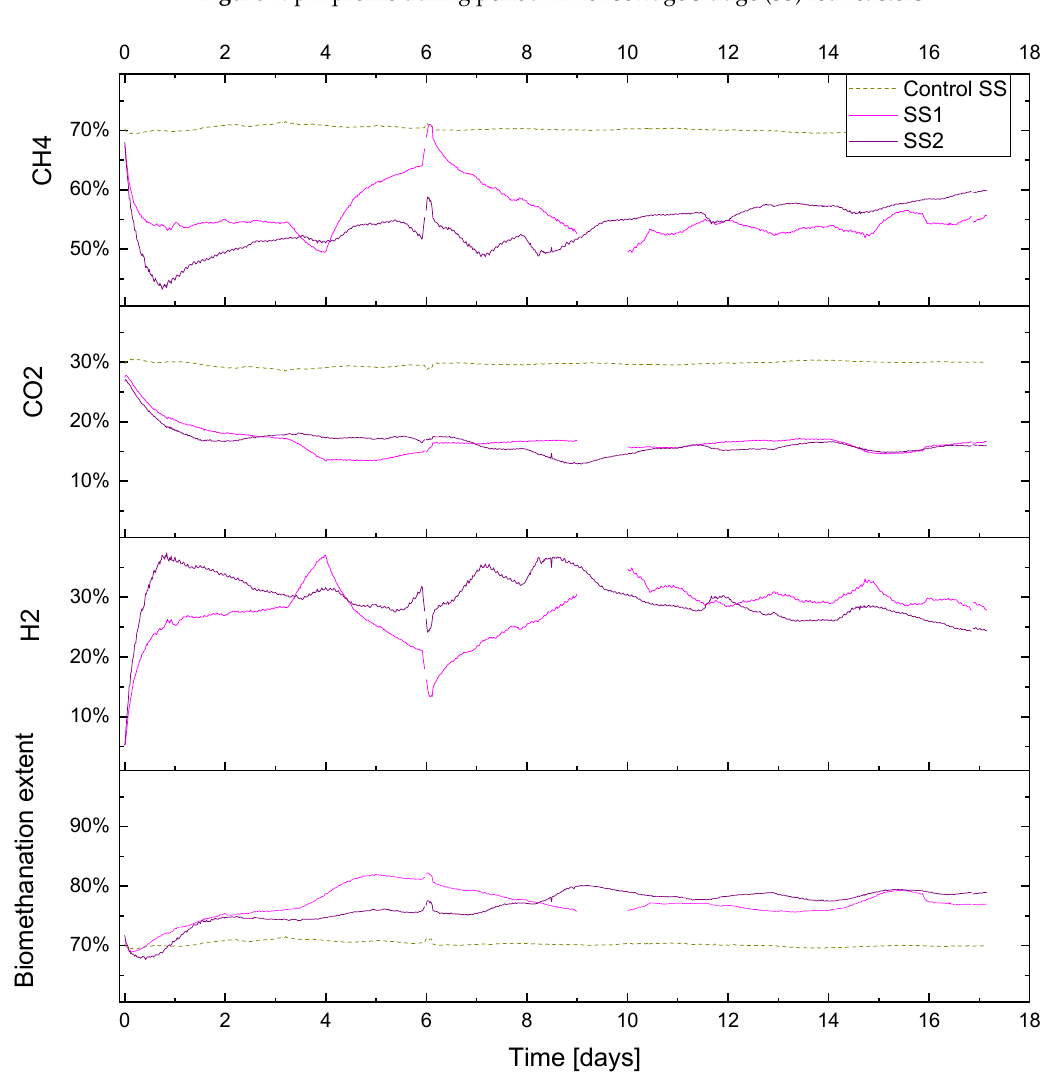
Figure 8. Gas composition (CH 4 , CO 2 , H 2 % vol.) and biomethanation extent (%) during period R1 for sewage sludge (SS) fed reactors .